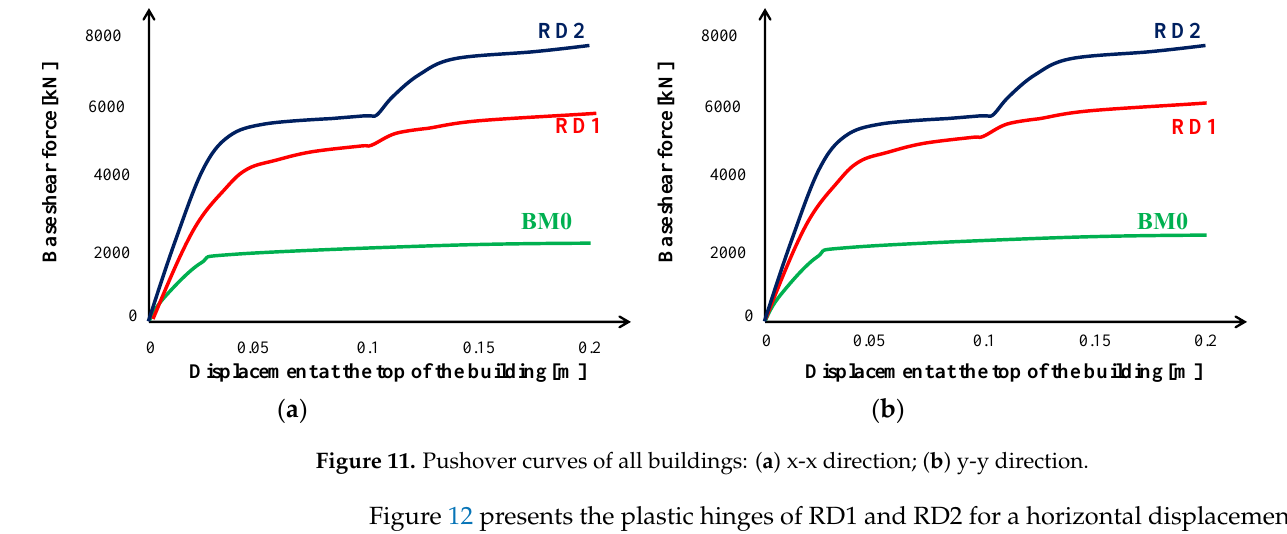
Figure 11. Pushover curves of all buildings: ( a ) x-x direction; ( b ) y-y direction.